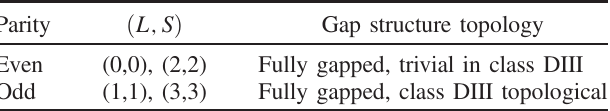
TABLE II. Total angular momentum J ¼ 0 pairing. Gap structure topology of fully gapped single-component pairing states with total angular momentum J ¼ 0 . See Refs.